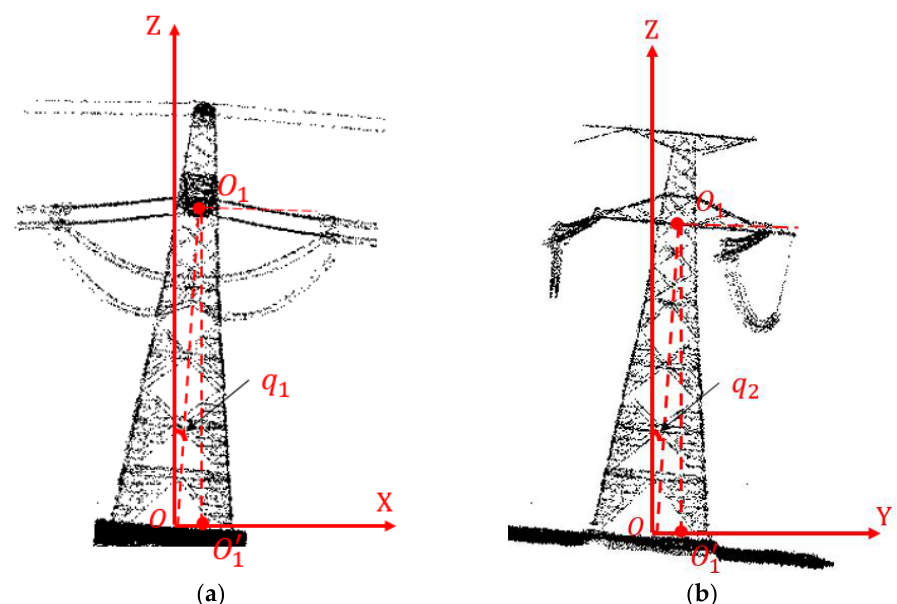
Figure 10. Central axis projection. (a) projection on YOZ plane; (b) projection on XOZ plane